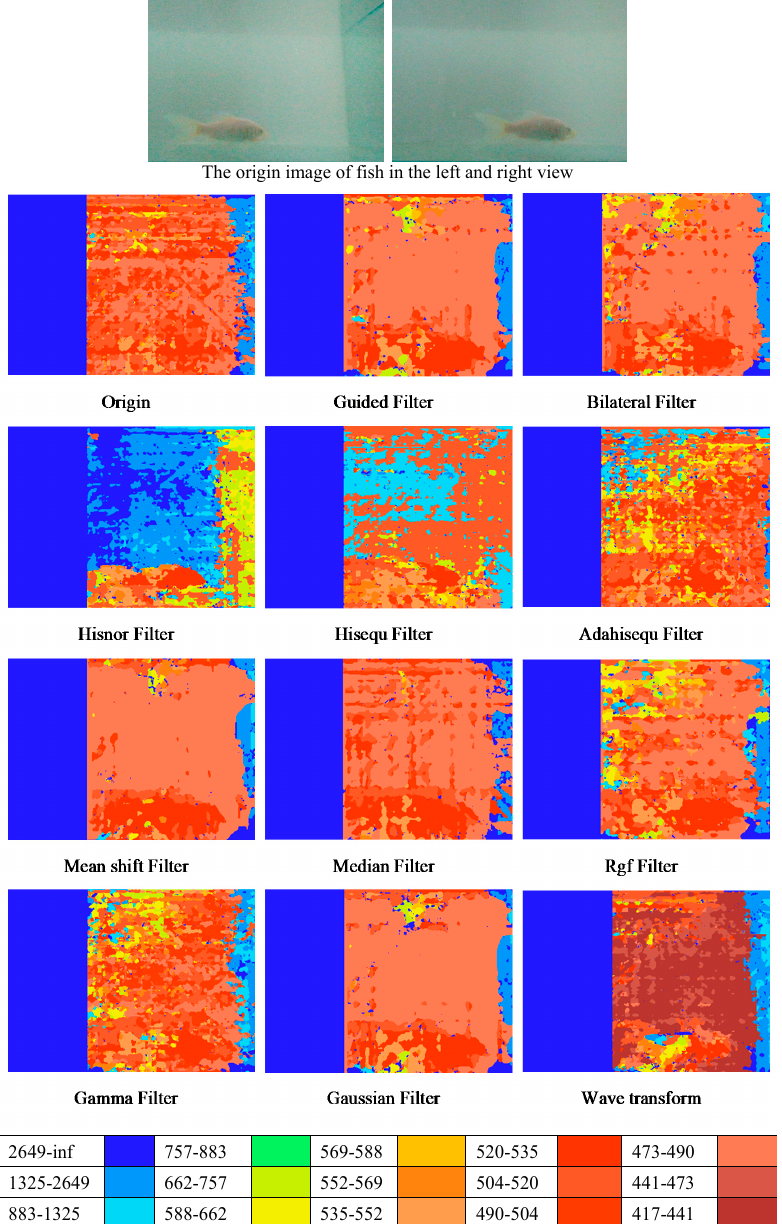
Figure 17. Results of filters.